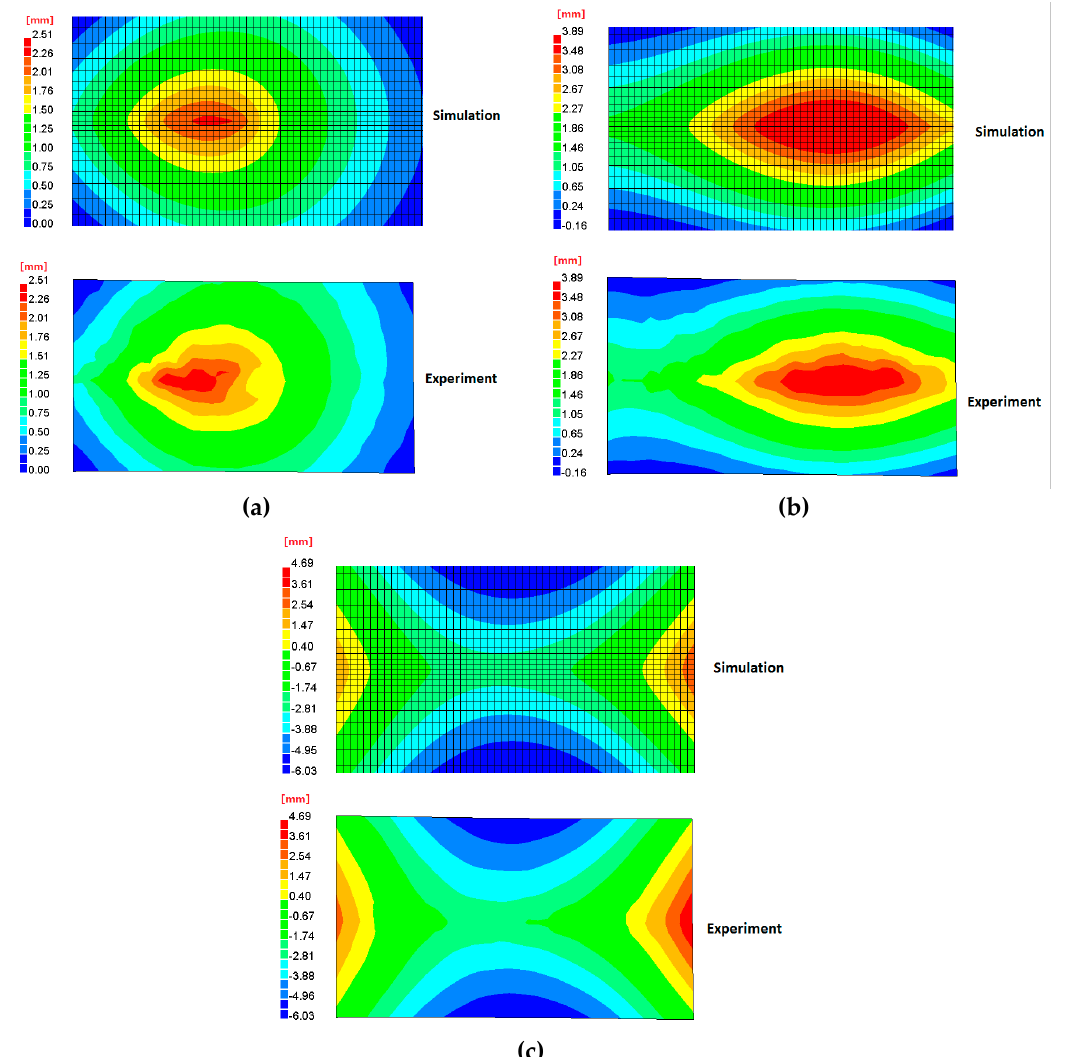
Figure 8. Comparison of plate out ‐ of ‐ plane deformation contour at different time. ( a ) t = 30 s; ( b ) t =60 s; ( c ) t = 400 s.